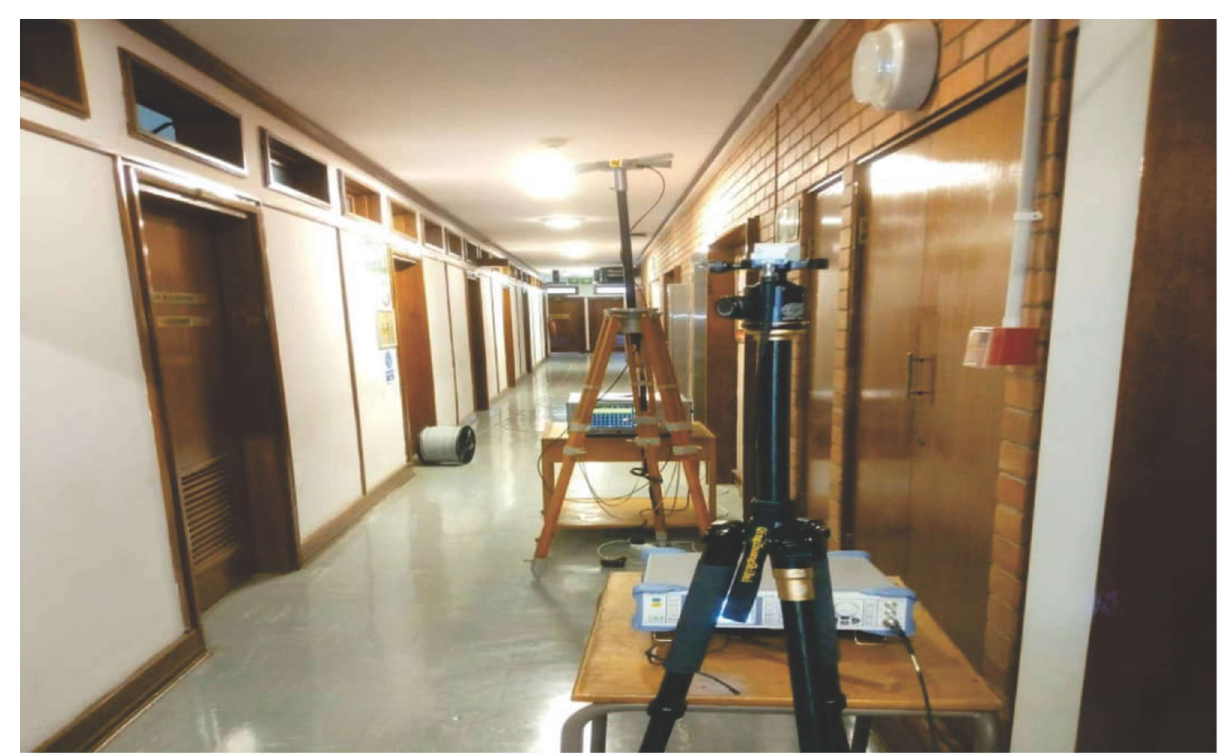
Fig 6. The setup of the Tx and the Rx in the indoor corridor